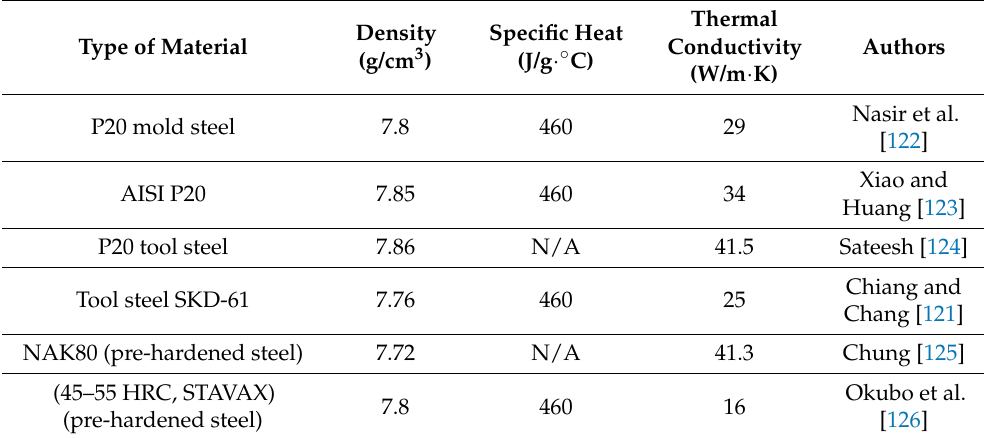
Table 3. Physical and mechanical properties of mold insert materials for CIM.